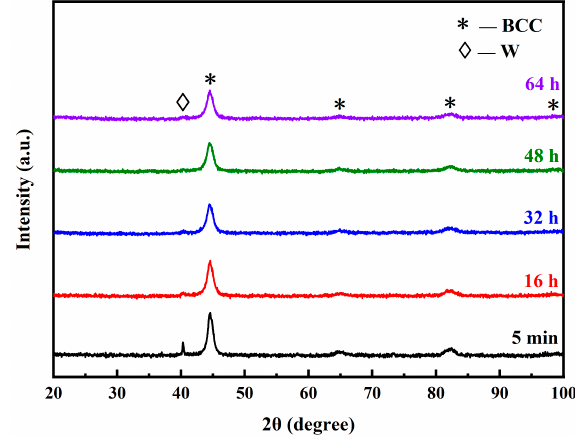
Figure 6. XRD patterns of the alloyed powders with different milling times.